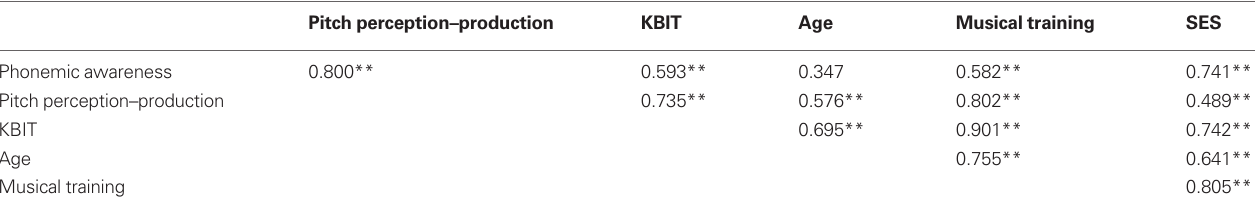
Table 1 | Pairwise correlation coefficients between variables of phonemic awareness scores, pitch perception–production scores, Kaufman brief intelligence test scores, age, musical training, and